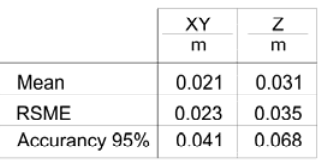
Figure 11: The mean, root square mean error (RMSE) and the accuracy derived from the figures in the table shown in figure 7. The accuracy at 95% confidence level is taken as planimetrically 1.7308 x RMSE and vertically as 1.9600 x RMSE.( Source - Geospatial Positioning Accuracy Standards. Part 3: National Standard for Spatial Data Accuracy.)